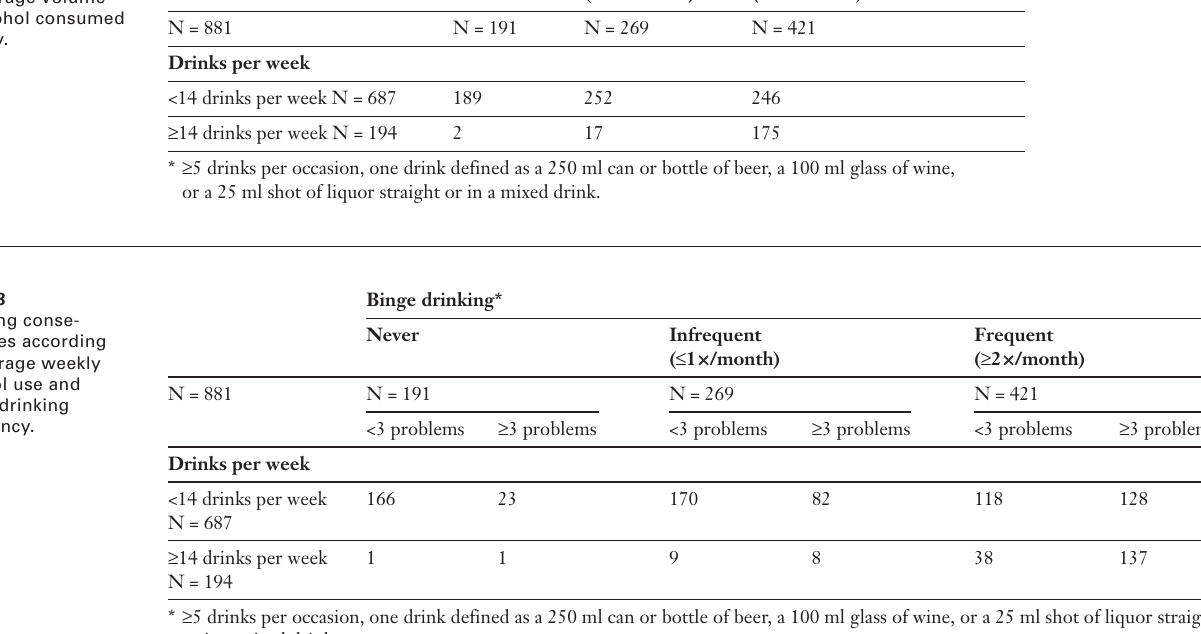
drinking according to average volume of alcohol consumed weekly.